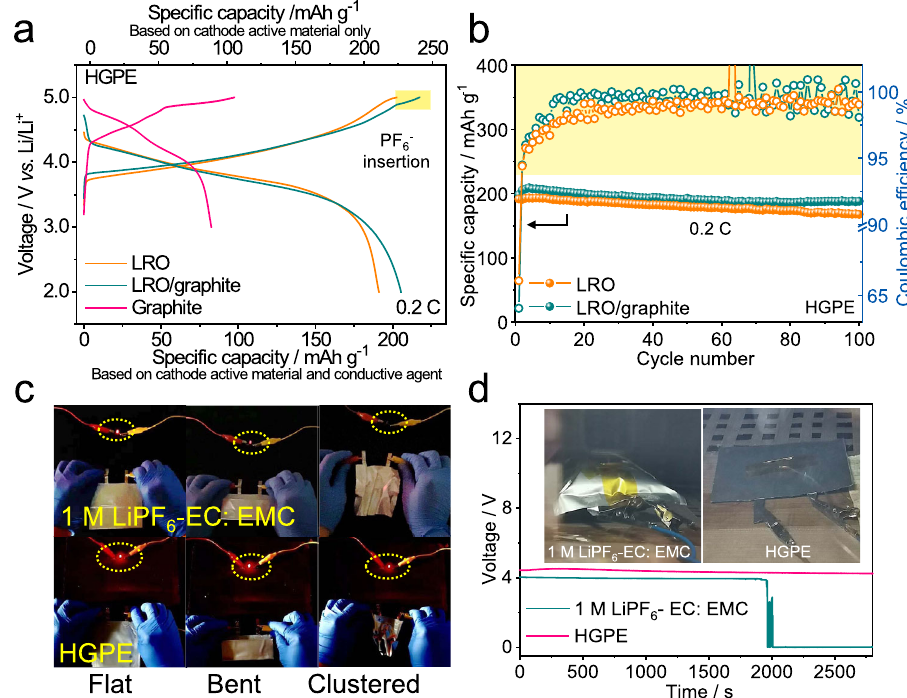
Fig. 6 Electrochemical energy storage performance of the SRLMBs. a Charge-discharge curves of the Li|HGPE| KS6 graphite, Li|HGPE | LRO, and Li| HGPE | LRO/graphite hybrid cells at 0.2 C. b Cyclic performances of Li|HGPE| LRO and Li|HGPE| LRO/graphite hybrid cells at 0.2 C. c Optical images of red LEDs powered by Li|1 M LiPF 6 -EC: EMC | LRO/graphite and Li|HGPE| LRO/graphite pouch cells. d Open circuit voltage changes of fully charged Li|1 M LiPF 6 -EC: EMC | LRO/graphite and Li|HGPE| LRO/graphite pouch cells at 130 °C during the aging time. Optical images of the pouch cells after aging at 130 °C for half an hour are shown in the